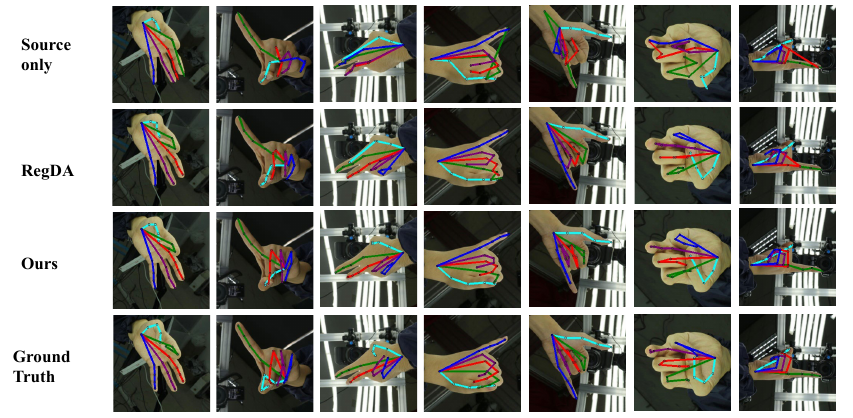
Figure 4. Qualitative results of different methods on the H3D dataset. The colors indicate the estimated skeletons of different